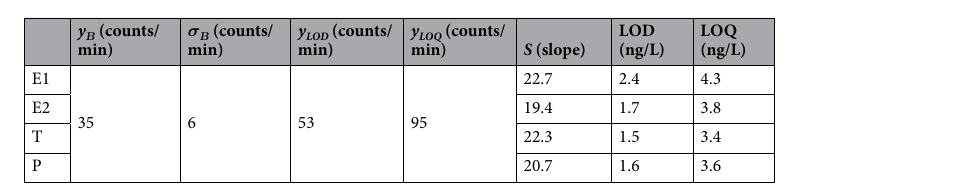
Table 2. Parameters obtained from calibration curves of tested